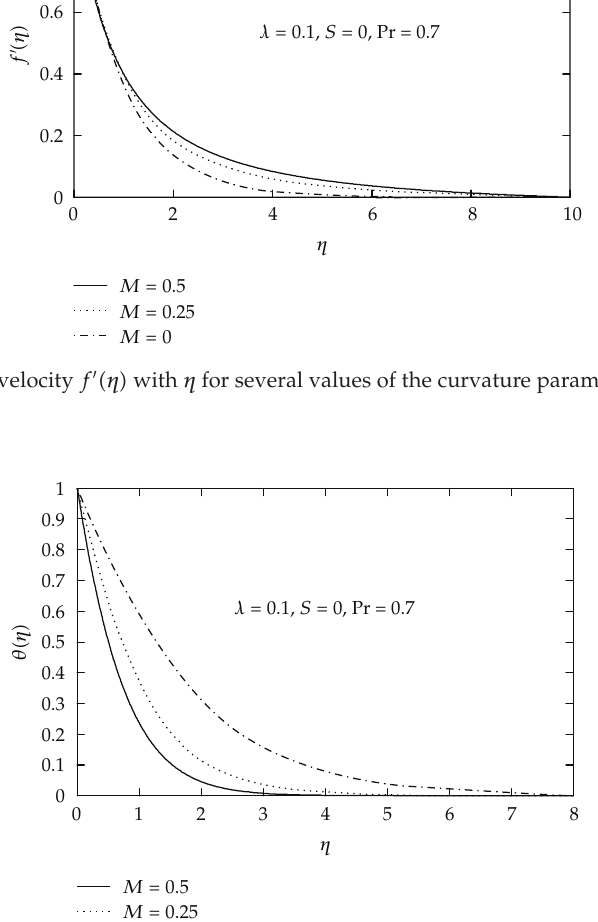
nondimensional parameters, namely, curvature parameter (cid:6) M (cid:7) , mixed convection parameter (cid:6) λ (cid:7) , thermal stratification parameter (cid:6) S (cid:7) , and Prandtl’s number (cid:6) Pr (cid:7)